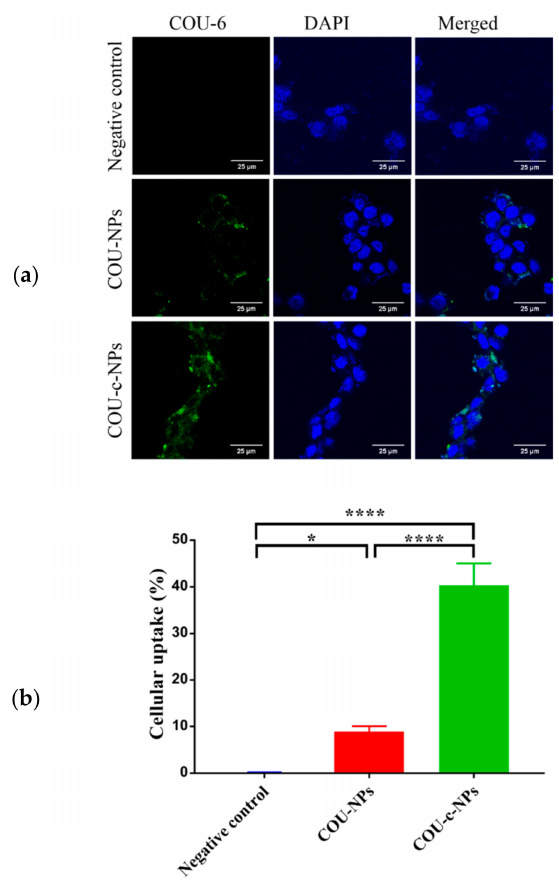
Figure 2. ( a ) In vitro CLSM images of MCF-7 cells treated with COU-NPs and COU-c-NPs for 2 h at 37 ◦ C, 5% CO 2 . All pictures show the nuclei (blue), COU-6 (green), and merged images. Bar equals 25 µ m; ( b ) Quantitative results of the cellular uptake of COU-6-loaded preparations expressed as the percentage of total cell number, **** p < 0.0001, * p <